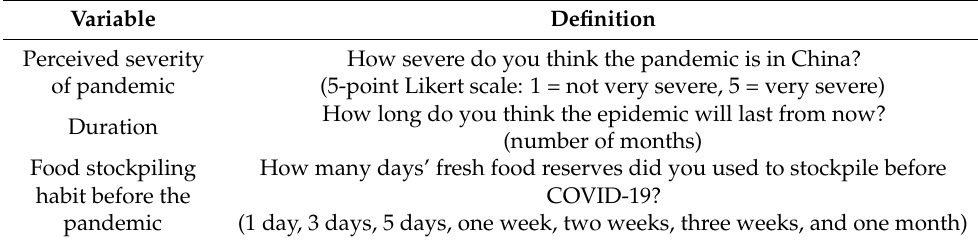
Table 1. Cont . Variable Definition Perceived